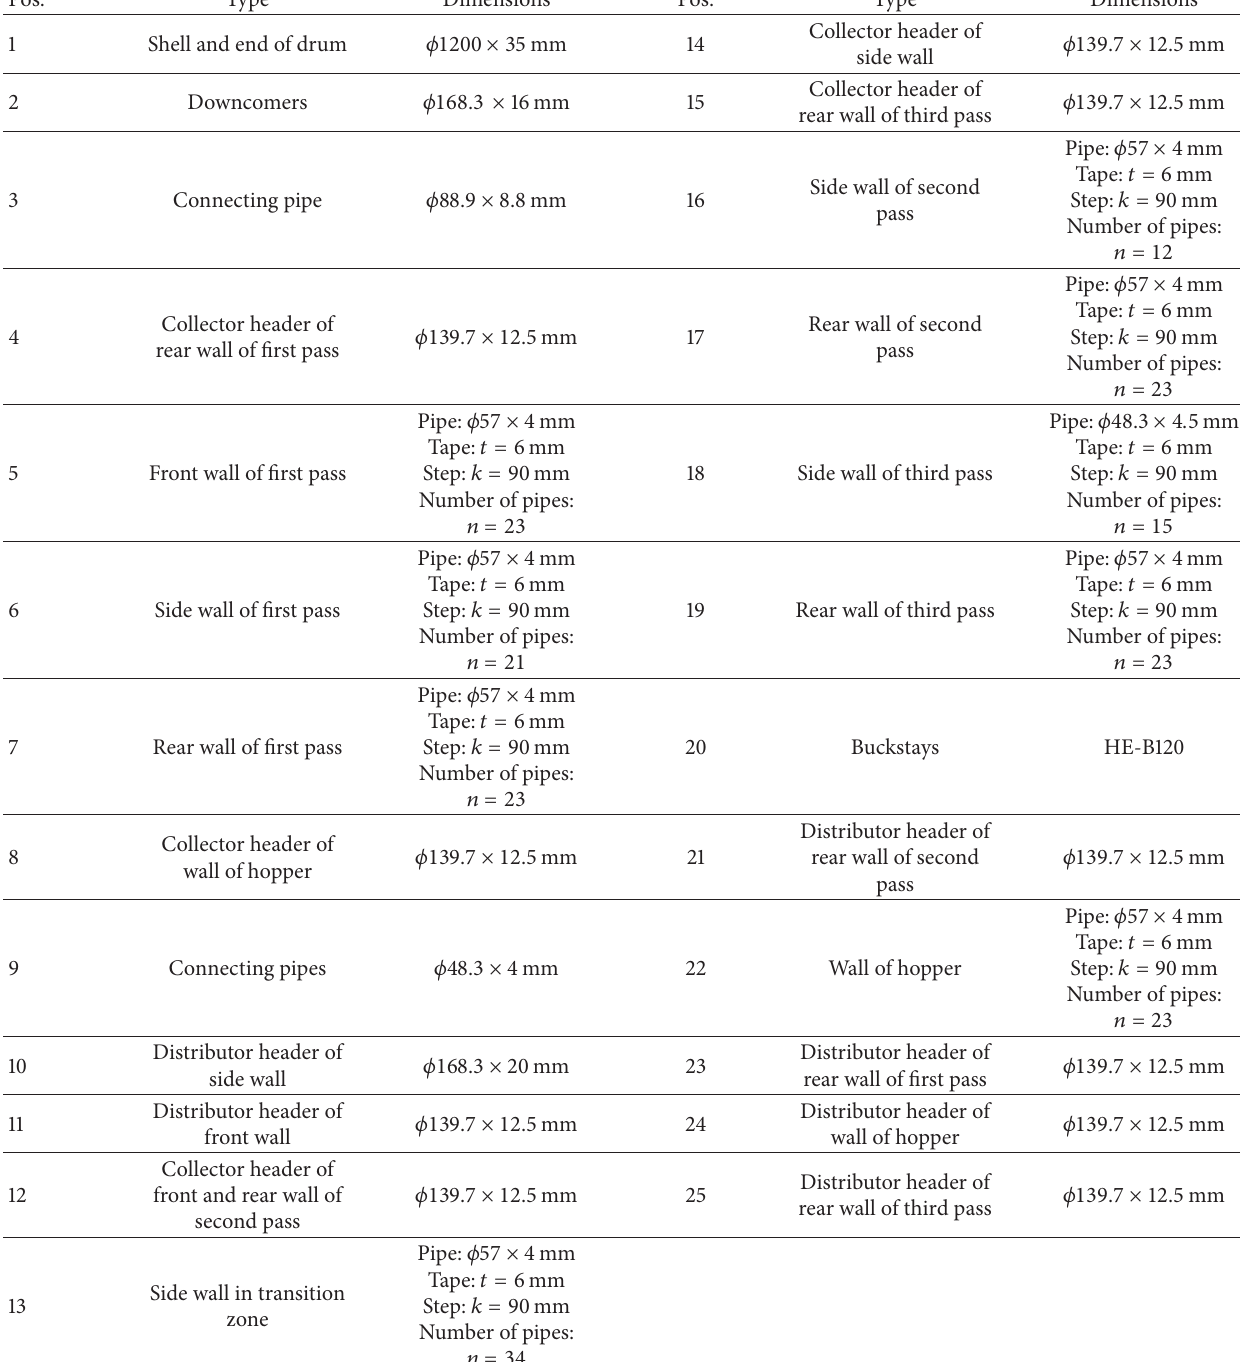
Table 1: List of positions according to Figure